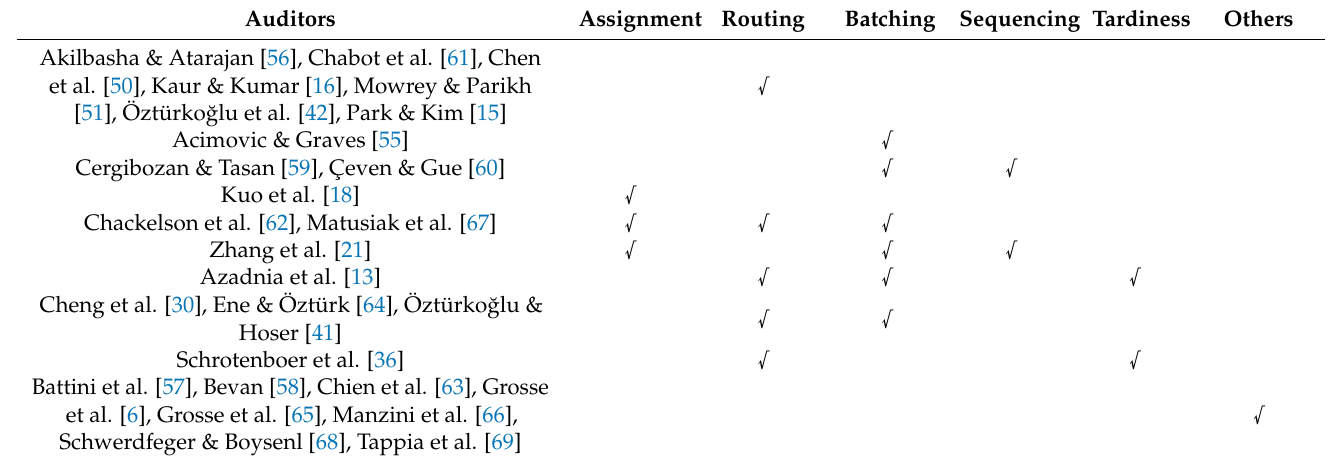
Table 6. Overview of the reviewed articles in minimizing cost.